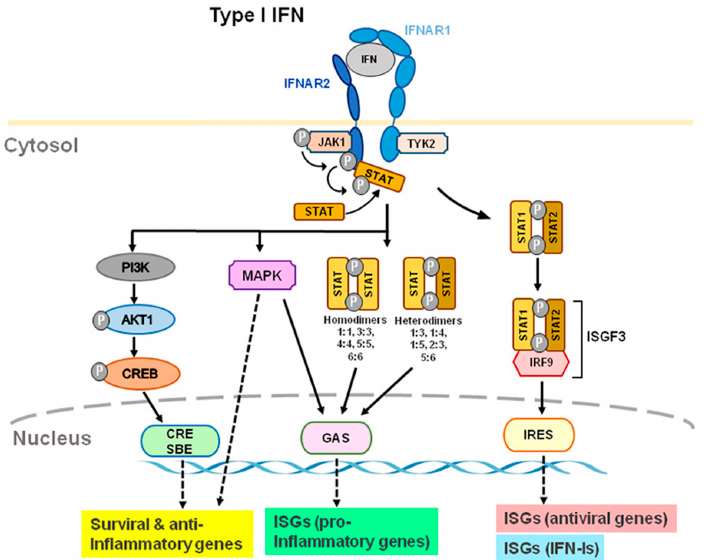
Figure 2. Type I IFN ‐ induced interferon receptor (IFNAR) signaling and gene expression. IFN ‐α and IFN ‐β transmit signals via IFNAR1 and IFNAR2 subunits. TYK2 and JAK1 are distinct com ‐ ponents of IFNAR1 and IFNAR2. Through ISRE, GAS, and CRE/SBE, TYK2 and JAK1 activation lead to activation of STAT1/2, STAT homo ‐ or heterodimers, PI3K, and MAPK, which activates transcription of ISGs, including antiviral, type ‐ I IFN, and pro ‐ inflammatory genes. Furthermore, TYK2 may form associations with membrane proteins, such as ion channels, which modulate the activity of cells rapidly. Abbreviations: JAK1, Janus kinase 1; TYK2, tyrosine kinase 2; STAT, signal transducer and activator of transcription; MAPK, mitogen ‐ activated protein kinase; PI3K, phos ‐ phoinositide 3 ‐ kinase; CRE, cyclic AMP response element; SBE, SMAD binding elements; GAS, IFN ‐γ‐ activated sites; ISRE, IFN ‐ stimulated response elements; ISG, IFN ‐ stimulated genes. Upon activating IFNRs and downstream signaling, IFN ‐ I could induce multiple an ‐ tiviral genes to inhibit virus replication in infected cells and prevent infection of nearby cells [3]. The suppressor of cytokine signaling (SOCS)1 is a potent inhibitor of JAK2 and could reduce IFN ‐ Is response. Production of suppressor of SOCS1 expression is main ‐ tained by IFN ‐β or high amounts of IFN ɑ 2 [24]. SOCS ‐ 1 also enhances immunological actions of IFN ‐γ but inhibits the adverse effect of unregulated IFN ‐γ responses by inhib ‐ iting STAT1 ɑ and decreasing the duration of IFN ‐γ signaling. By either binding directly to receptors or inhibiting JAK1, JAK2, and TYK2 directly, SOCS3 inhibits the receptor signaling but not JAK3 signaling. I n comparison to SOCS1, SOCS3 is less potent than SOCS1 in suppressing IFN ‐γ signaling. By suppressing STAT3 signaling, SOCS3 also in ‐ hibits Th17 differentiation. Through IL ‐ 6 signaling, SOCS5 negatively regulates STAT6, an essential signaling molecule for IL ‐ 4, which inhibits Th2 differentiation [20]. Many types of viral infections, including hepatitis C and hepatitis B, have been successfully treated with IFN ‐ Is. Multisystem autoimmune diseases, such as multiple sclerosis, are also treated with IFN ‐ Is [25]. IFN ‐ Is also were used to treat cancer through directly activating cytotoxic T lymphocytes, NK cell activation, induction of tumor cell death, and inhibition of angiogenesis. Treatment for melanoma with IFN ‐ Is is reported to effectively improve disease ‐ free survival [26]. IFN ‐ Is can interact with host cells to induce protective immunity; e.g., IFN ‐ I can enhance antibody production by dendritic cells. IFN ‐ Is were also immunosuppressants and anti ‐ inflammatory mediators by induction of programmed cell death ‐ ligand 1 (PD ‐ L1) [27] and anti ‐ inflammatory cytokines (e.g., IL ‐ 10) [14] as well as blocking the expression of pro ‐ inflammatory mediators, such as matrix metalloproteinase 9 (MMP ‐ 9), ICAM ‐ 1, VCAM ‐ 1, and tumor necrosis factor ‐α (TNF ‐α )[28,29].